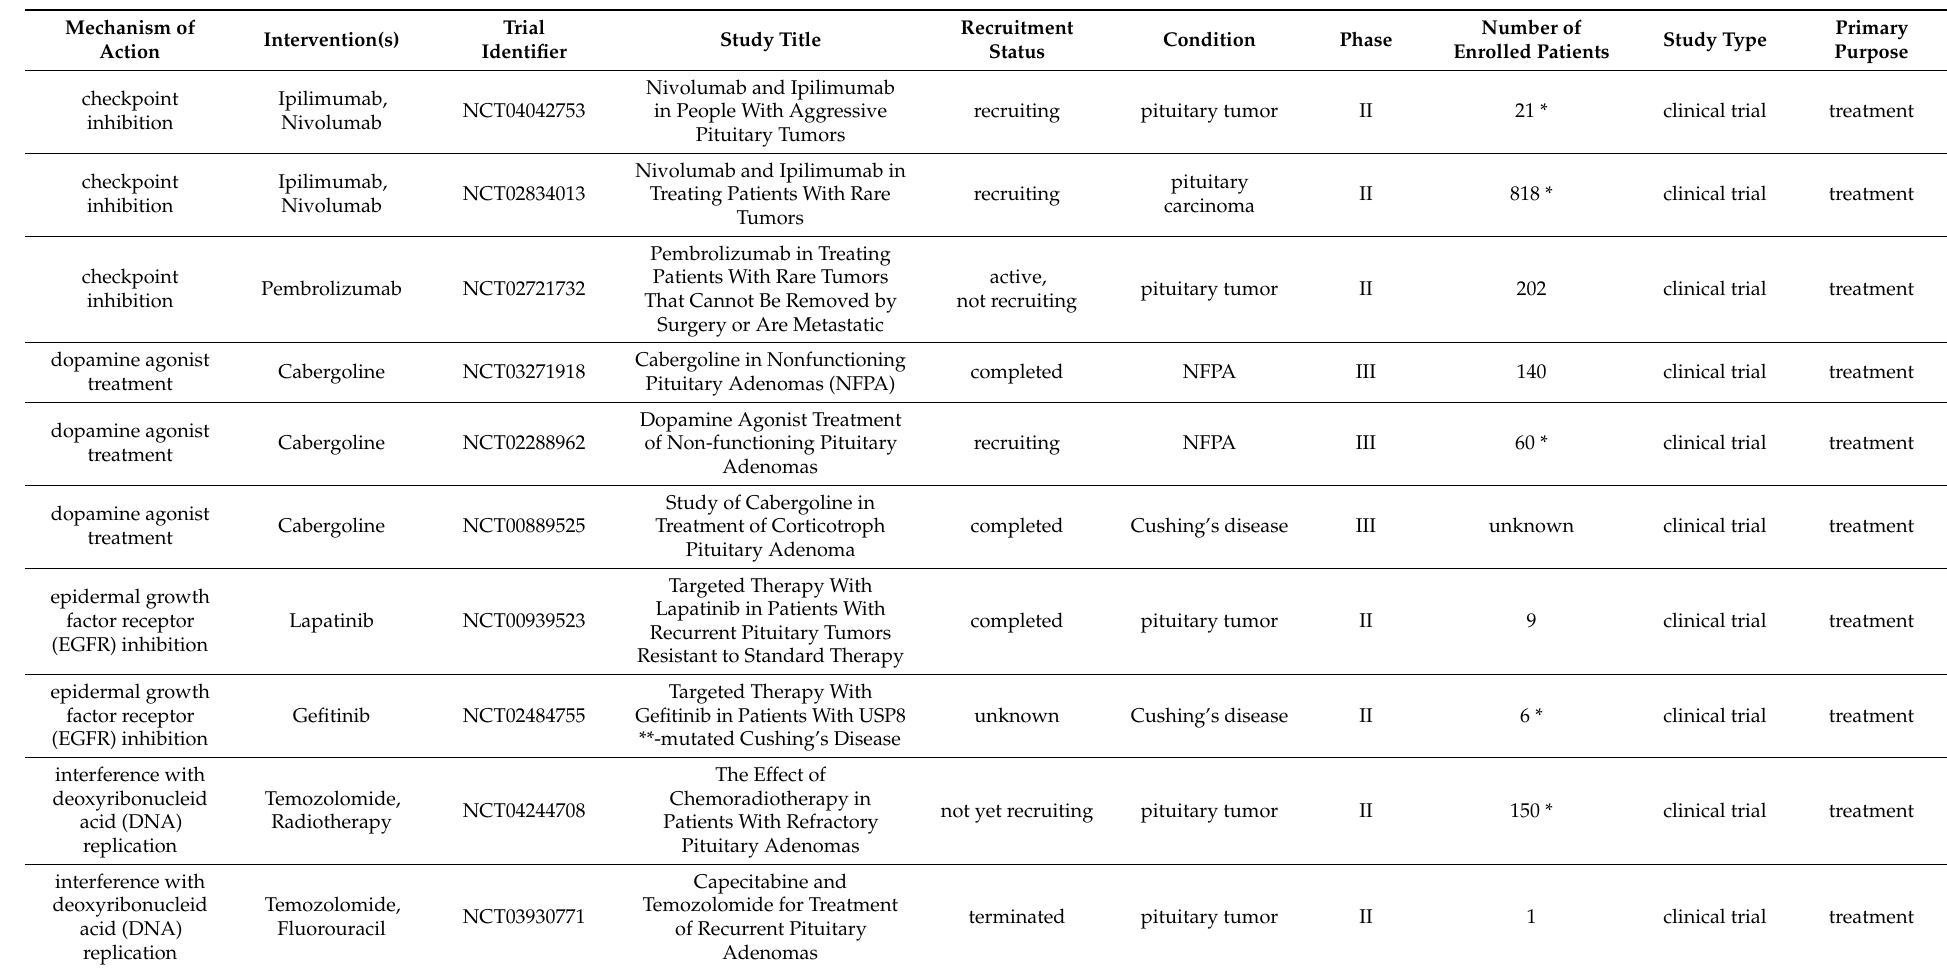
Table 1. List of clinical trials related to the treatment of aggressive PAs (https://clinicaltrials.gov [26] (accessed on 6 November